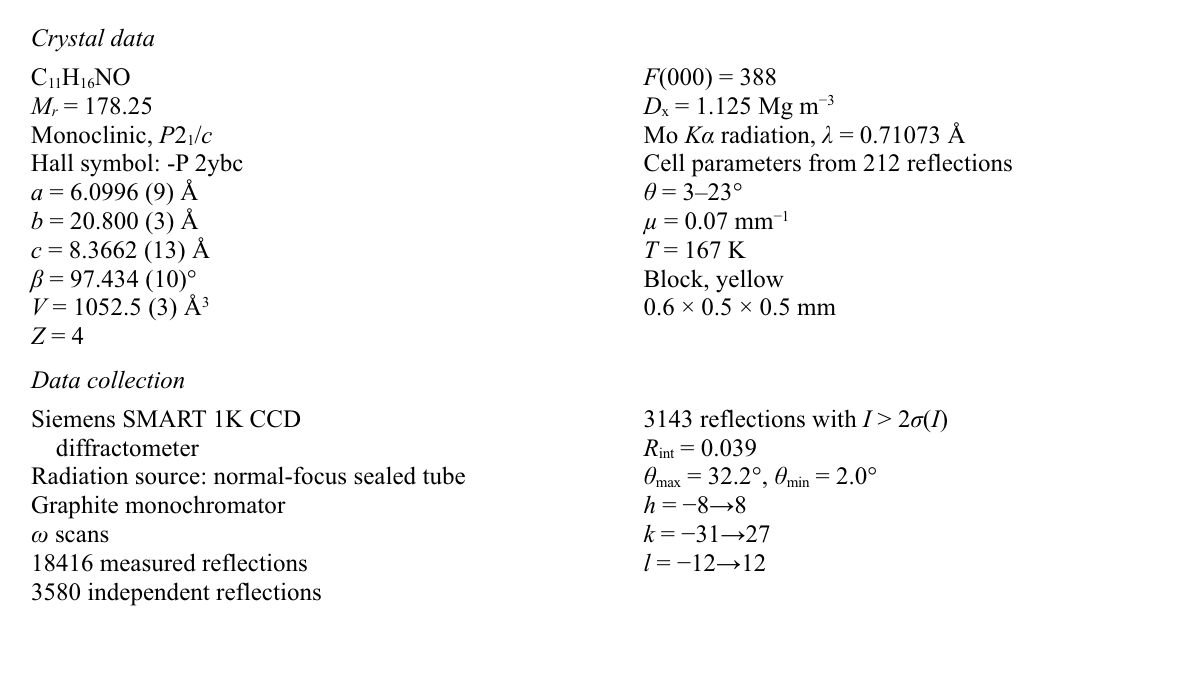
The crystal packing of the title compound, viewed down the a axis. Intermolecular C dashed